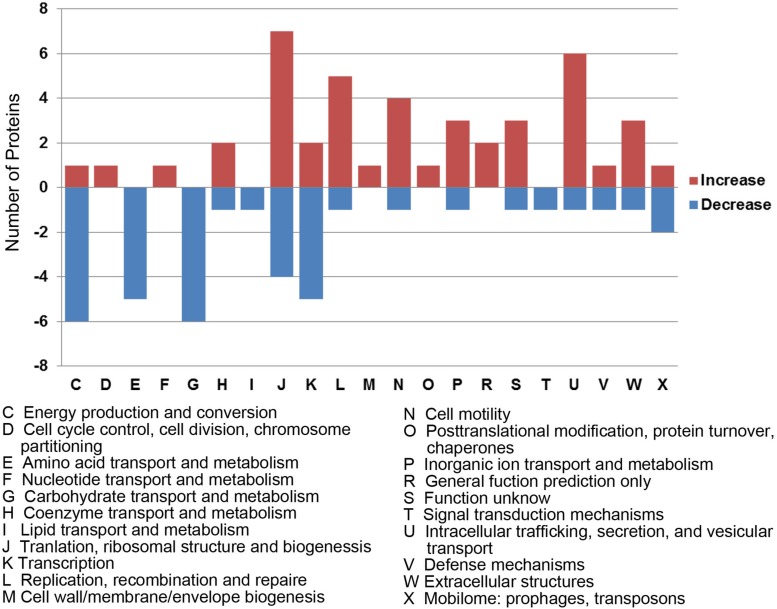
Functional classification of differentially expressed proteins according to clusters of orthologous groups (COGs). Histogram illustrating the COG functional categories and the associated protein number. –, proteins with decreased expression.